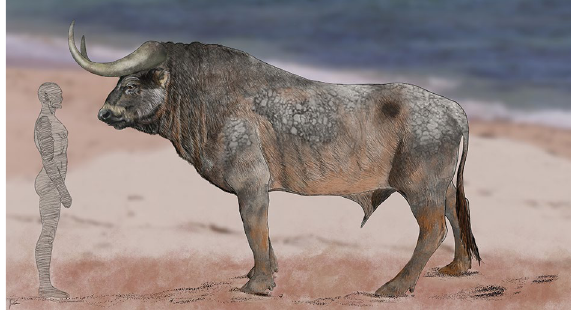
Figure 8. Reconstitution of the size of the aurochs based on the maximum size of the tracks found in the TTS, in a context of beach environment where they were produced (artwork of José María